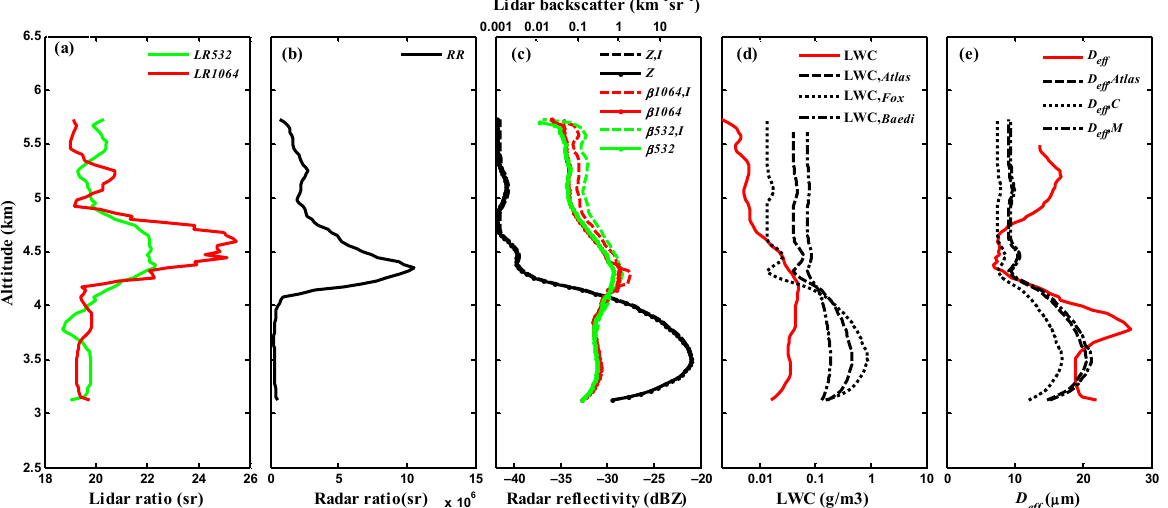
Figure 13. The inversion results at 13:00 p.m. on 16 October 2019: ( a ) lidar ratio at different wavelengths ( LR 532 , LR 1064 ); ( b ) radar ratio ( RR ); ( c ) lidar backscatter at different wavelengths ( β 532 , β 1064 ) and radar reflectivity factor ( Z ) (initial value subscript I ); ( d ) liquid water content (LWC); ( e ) effective diameter ( D eff ).